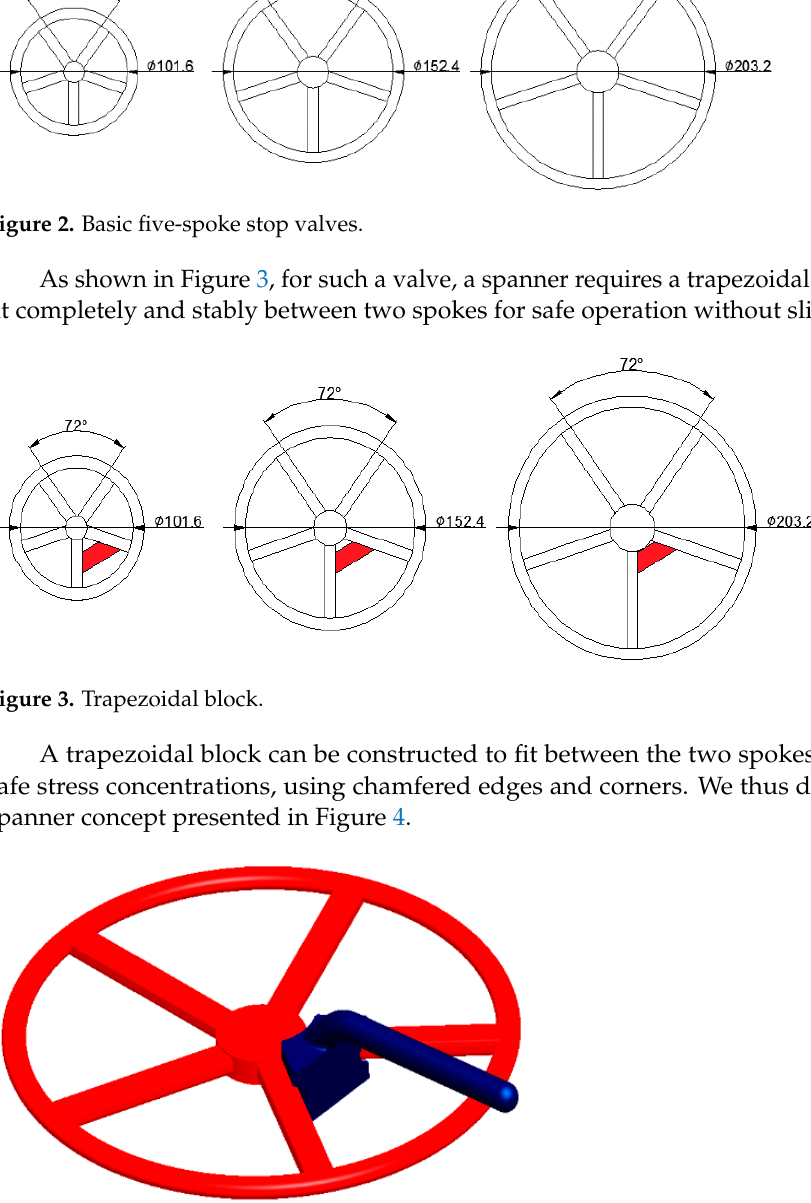
Figure 2. Basic five-spoke stop valves.